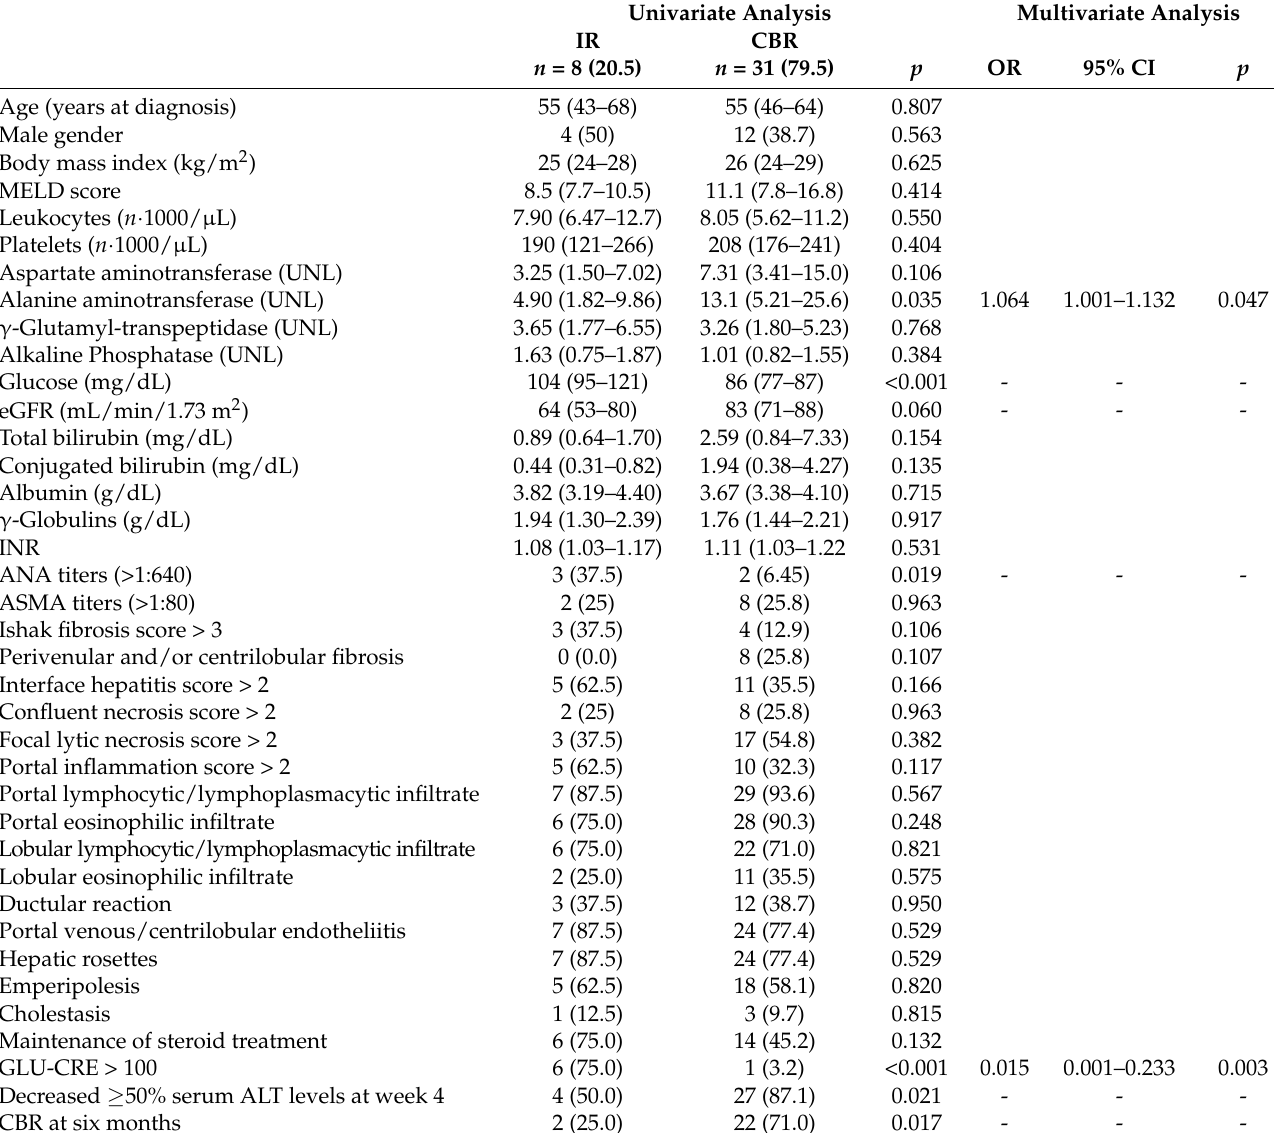
Table 5. Association among baseline demographic, clinical, and histological characteristics of patients ( n = 39) concerning the achievement of >12 months (CBR) or insufficient response (IR) defined as the normalization of serum transaminases and IgG levels below the upper normal limit (UNL) and as lack of CBR, respectively. Categorical parameters are presented as frequencies (%), and the Pearson chi-squared test was used for statistical comparisons. Continuous variables are presented as medians (interquartile range), and the rank-sum test (Mann-Whitney) was used for statistical comparisons. Stepwise regression with a forward approach was used to discriminate independent predictive variables associated with the achievement of CBR. Univariate Analysis Multivariate